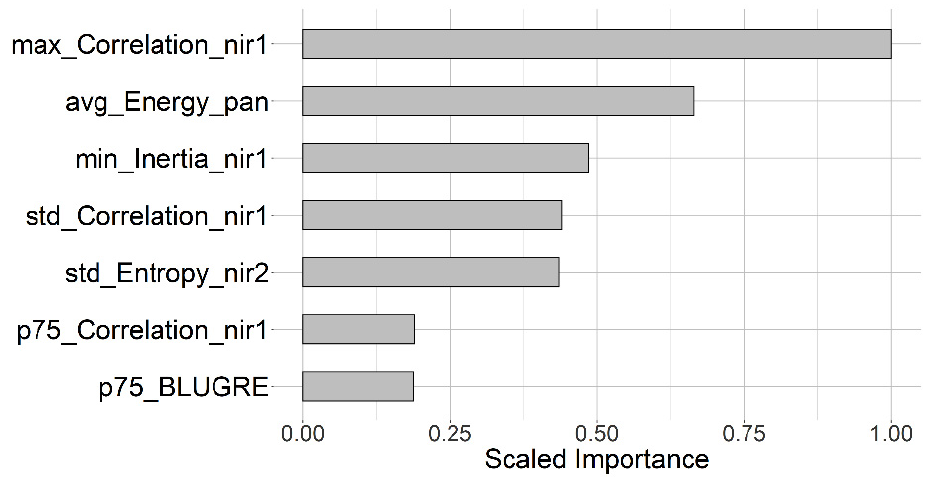
Figure 4. Scaled feature importance of best (GBM) binary classification model. Importance is calculated as difference in squared error before and after a split using a particular feature. Variable p75_BLUGRE is the 75% percentile of the NDSI (Normalised Difference Spectral Index) calculated from Blue and Green band.